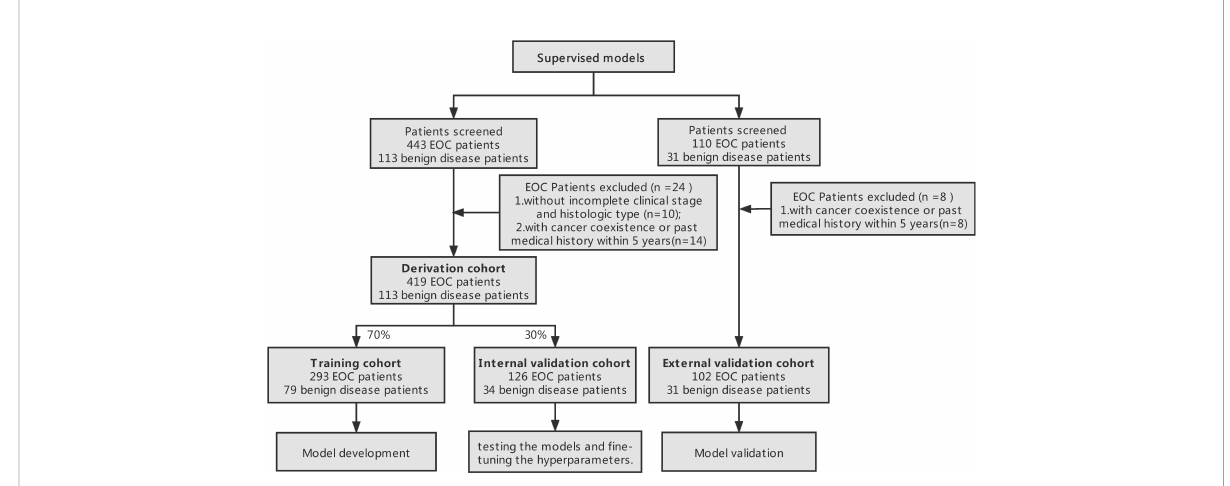
FIGURE 1 Study design process. Derivation datasets originated from the Department of Obstetrics and Gynecology, Renji Hospital and external validation cohort originated from Obstetrics and Gynecology Hospital Af fi liated to Fudan